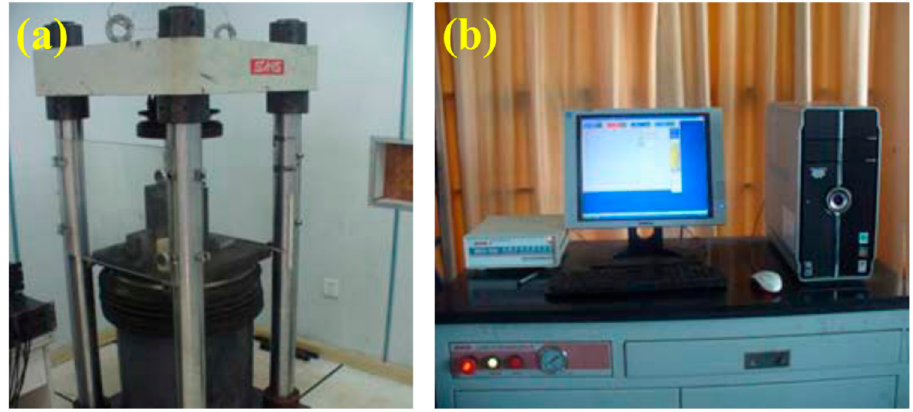
Figure 3. Axial compressive loading subsystem. ( a ) Loading frame. ( b ) Hydraulic drive device and controller host.